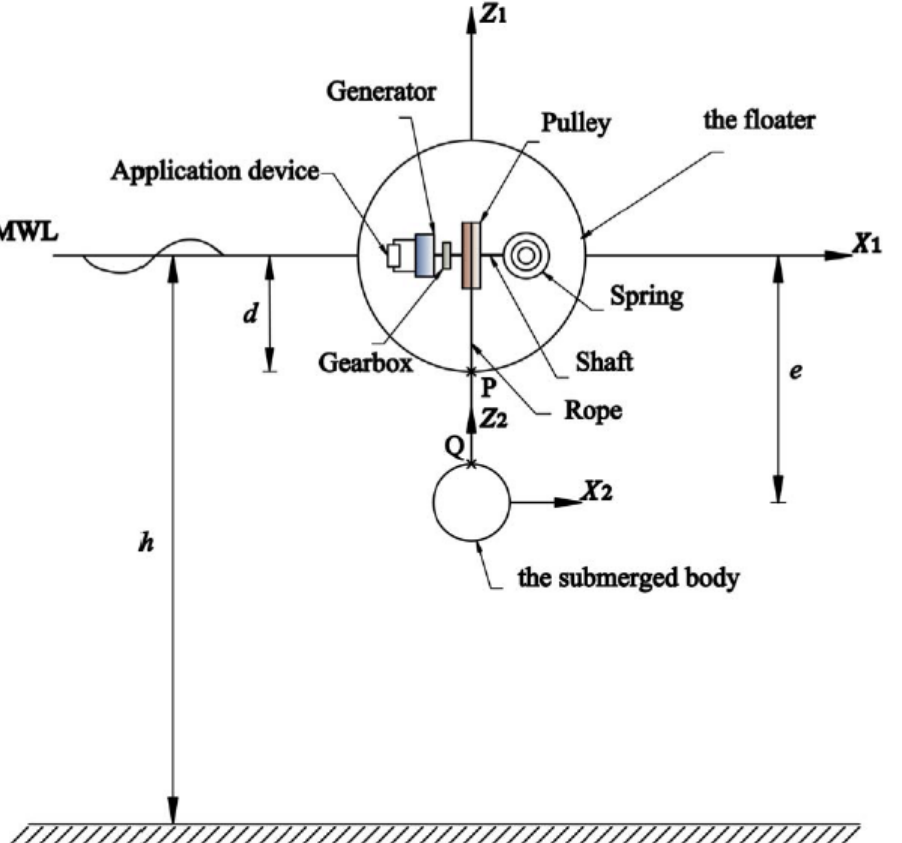
Figure 21. A two-body WEC with a rope/pulley/spring sealed PTO [109] .